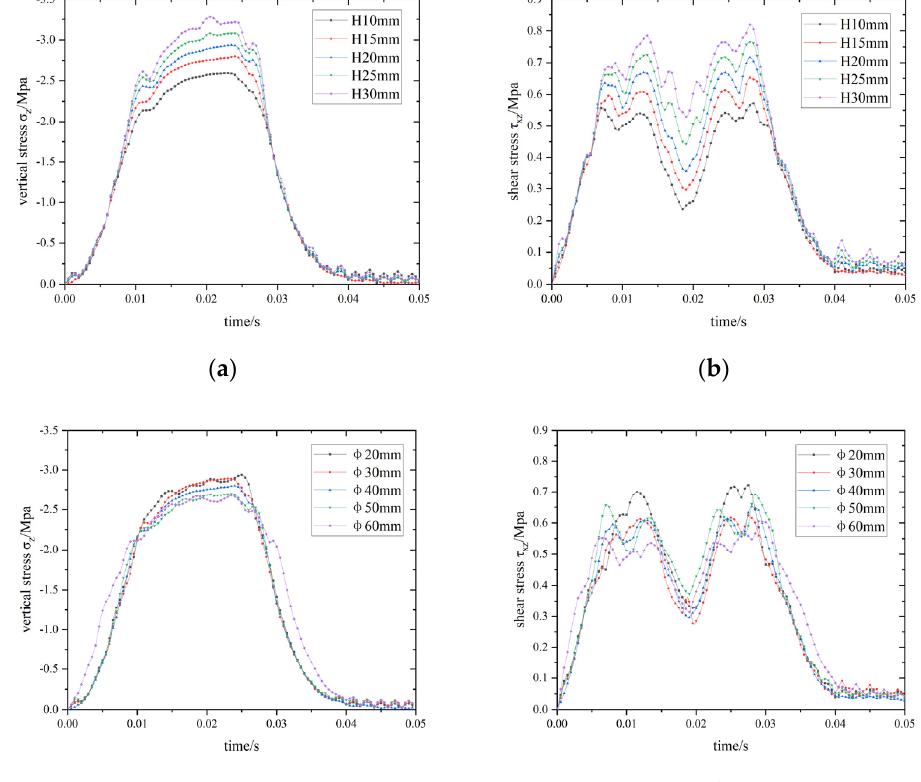
Figure 15. Maximum stress–time curve of elements at the interface under different sensor sizes. ( a ) σ z -time curve, sensor thicknesses; ( b ) τ xz -time curve, sensor thicknesses; ( c ) σ z -time curve, sensor diameters; ( d ) τ xz -time curve, sensor diameters.